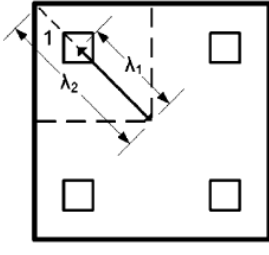
Figure 5. Top-view of panel design concept [2].